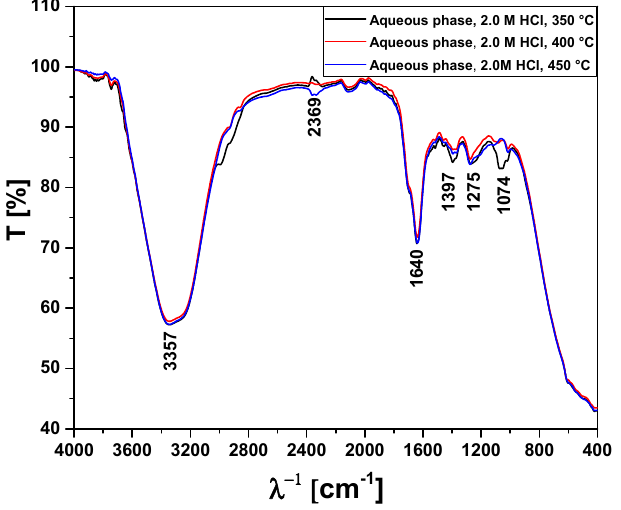
Figure 11. FT-IR analysis of aqueous phase obtained by pyrolysis of Açaí seeds, activated with 2.0 HCl solution, at 350, 400, and 450 ◦ C, 1.0 atmosphere, in laboratory M HCl solution, at 350, 400, and 450 °C, 1.0 atmosphere, in laboratory scale.